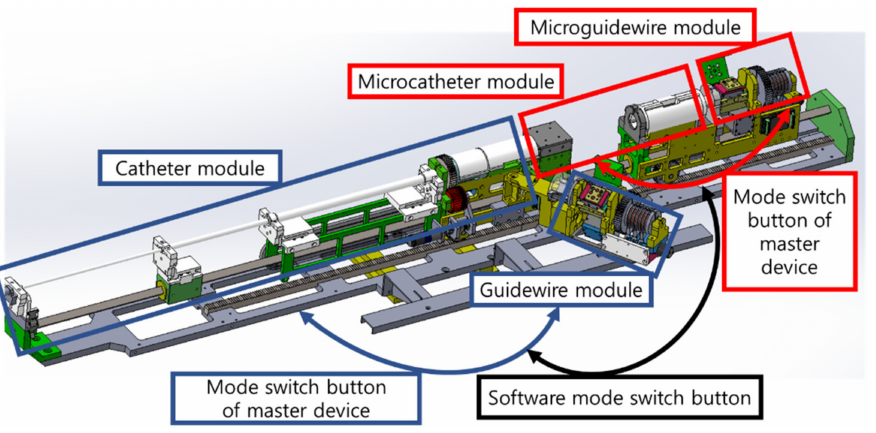
Figure 5. Mode switch method of the 7 DOFs VI slave robot using the two mode switch